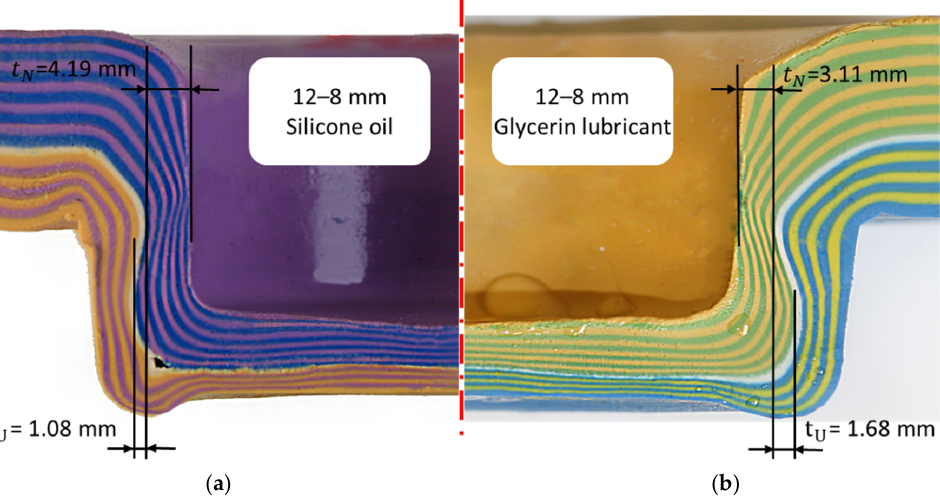
Figure 11. Comparison between cross section of plasticine clinch joint using glycerin and silicone oil: ( a ) left; silicone oil lubricant (S3) and ( b ) right; glycerin lubricant (S4). Table 3. Interlock of each layer in experiments S3 (12–8 mm) with silicone lubricant. Layer No.